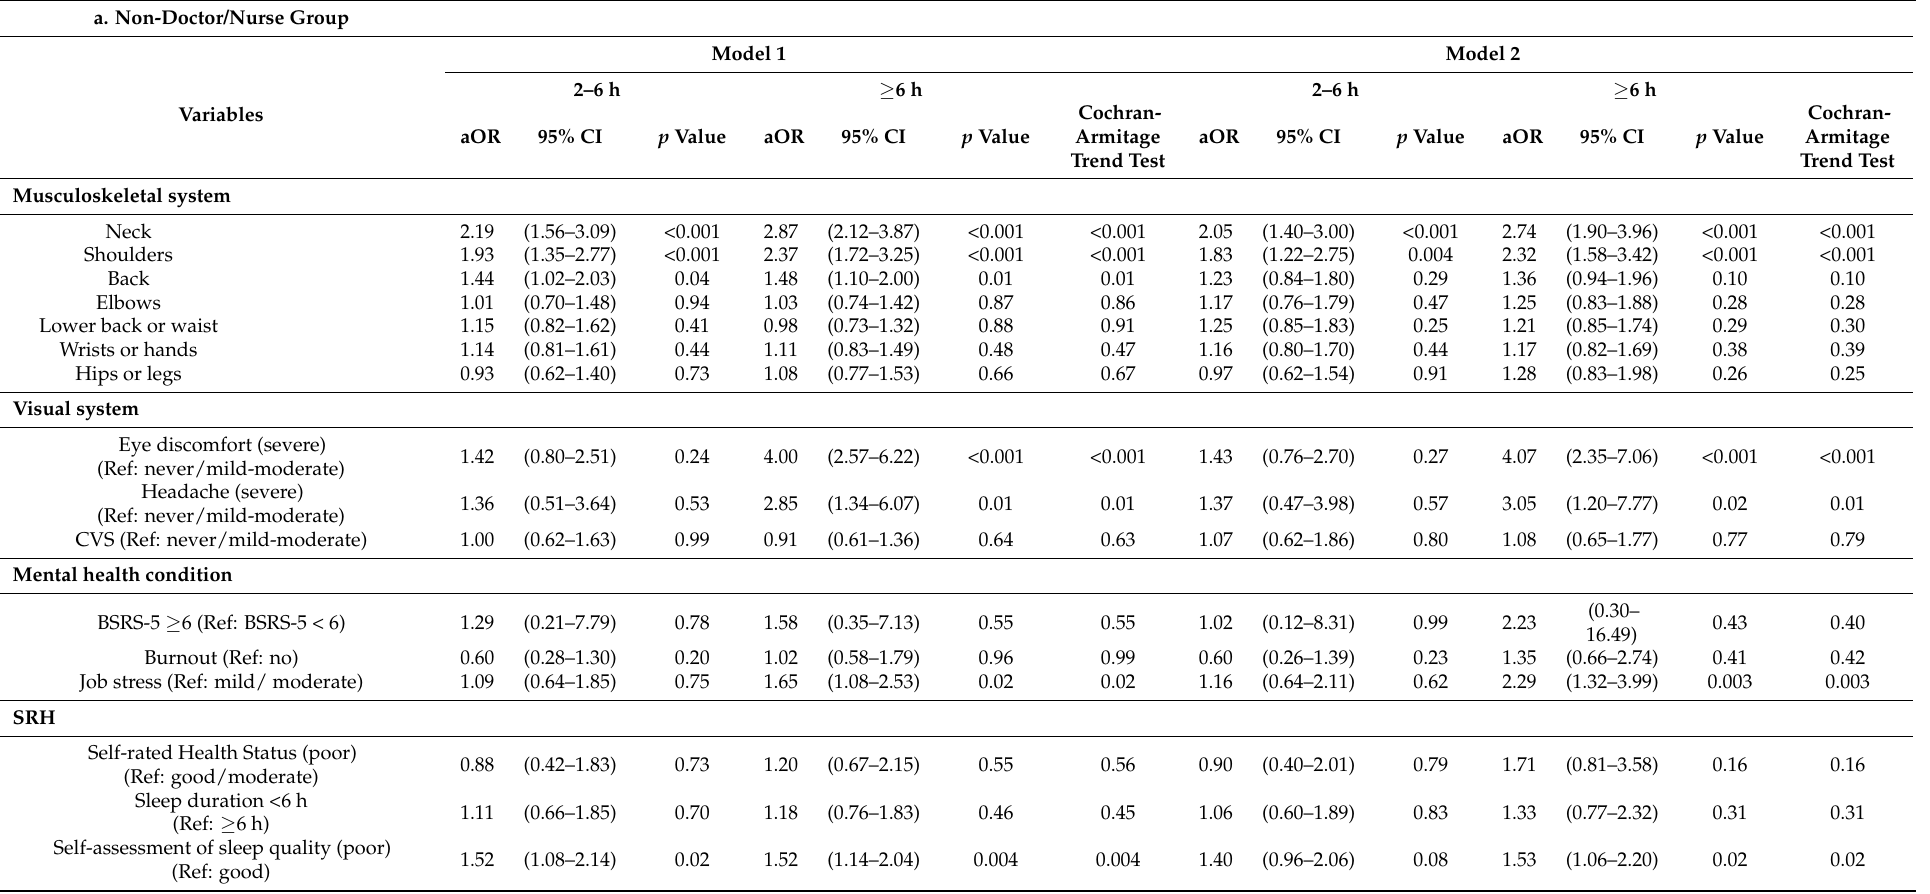
Table 3. Adjusted odds ratio (aOR) and 95% CI of the health condition according to profession with different durations of daily VDT working